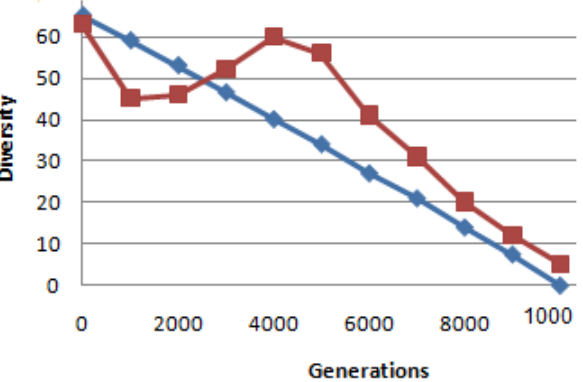
Figure 12. Diversity curve with fifty (50) generations.